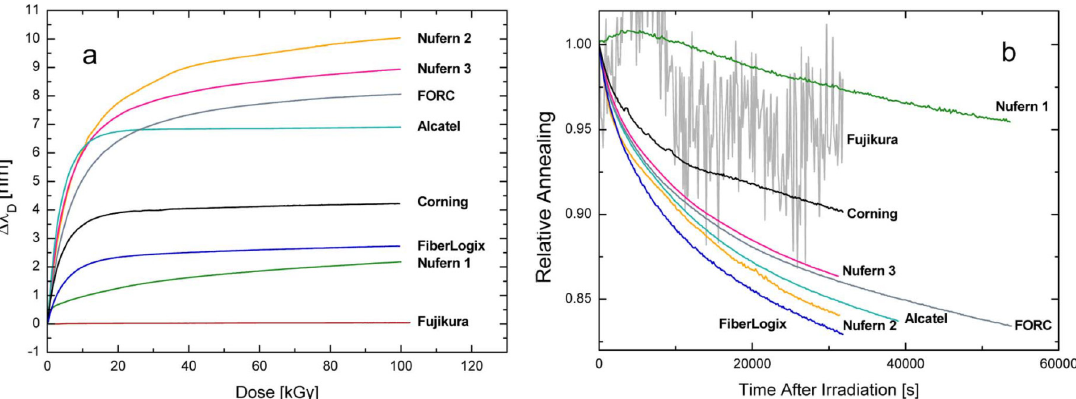
Figure 2. ( a ) Radiation induced wavelength shift of CLPGs at a dose rate of 0.9 Gy/s and ( b ) relative recovery after the irradiation. © 2010 IEEE. Reprinted with permission from [65]. recovery after the irradiation. © 2020 IEEE. Reprinted with permission from